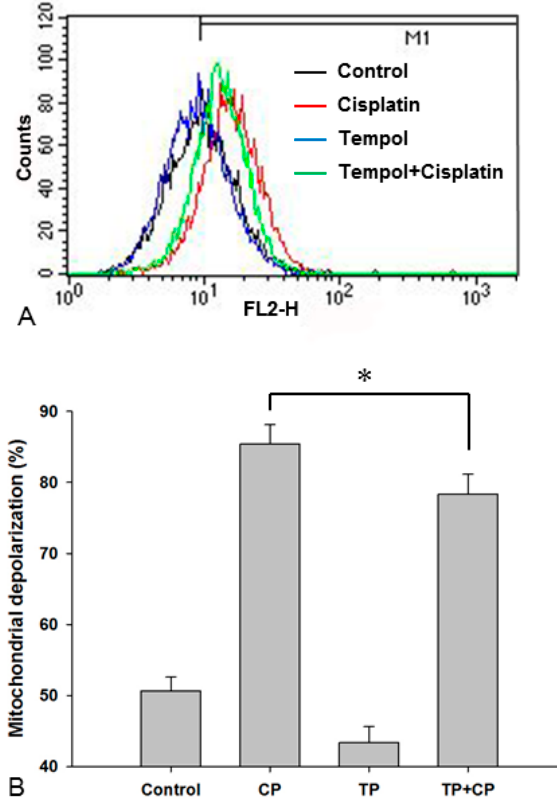
Figure 6. Mitochondrial membrane potential was determined by flow cytometry and representative histograms of mitochondrial membrane potential intensity are illustrated in ( A ). Exposure to 30 μ M cisplatin alone for 24 h increased mitochondrial depolarization. This increase in mitochondrial depolarization was significantly inhibited in cells pretreated with 50 μ M Tempol for 2 h before cisplatin exposure ( B , * p < 0.05, paired Student’s t -test). Each group was tested in triplicate. CP, cisplatin; FL2-H, fluorescence channel 2 height; TP, Tempol.